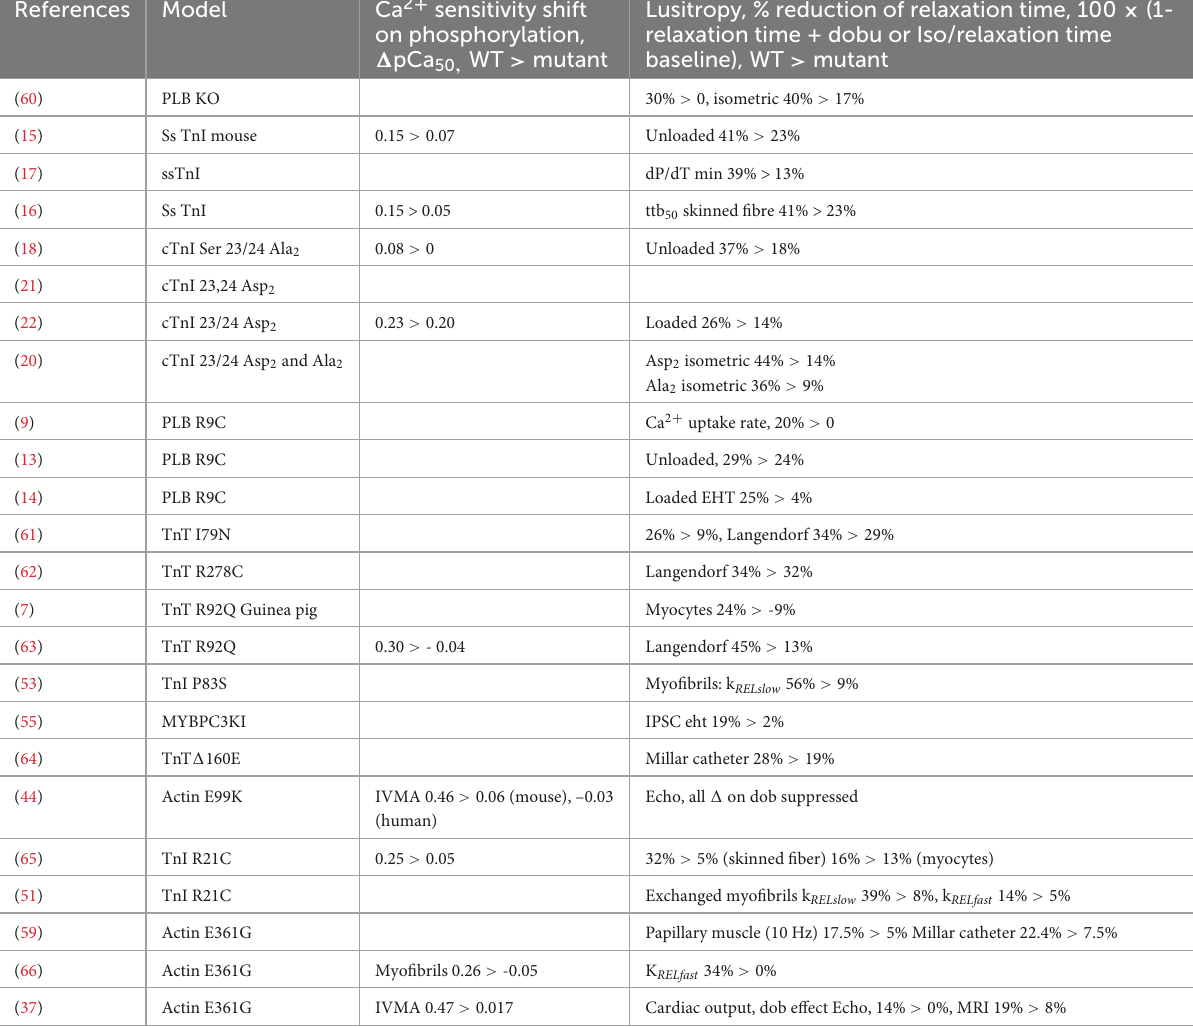
TABLE 1 Animal models of impaired